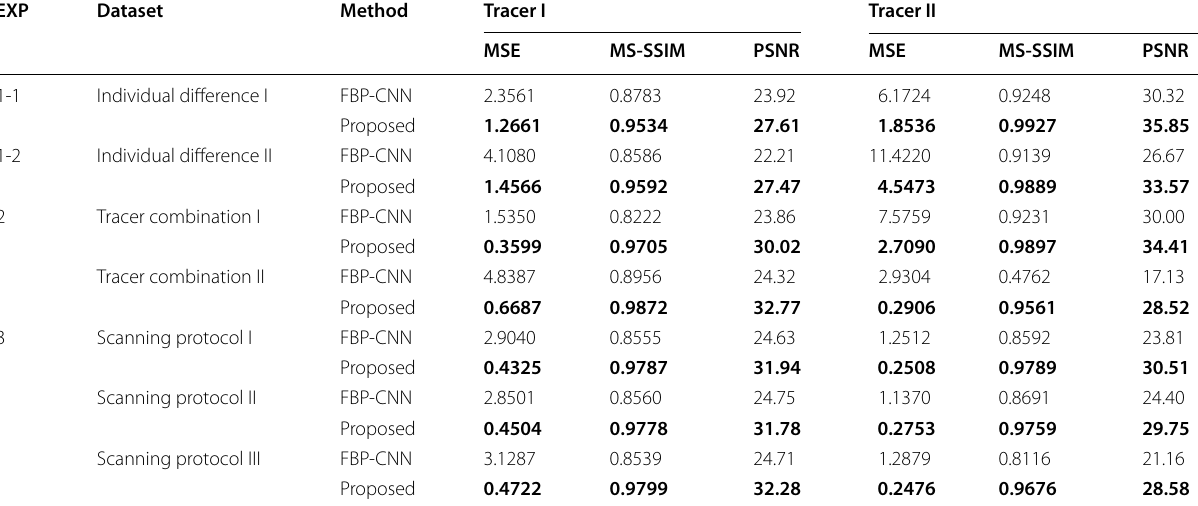
Table 2 Quantitative results of the simulation experiments